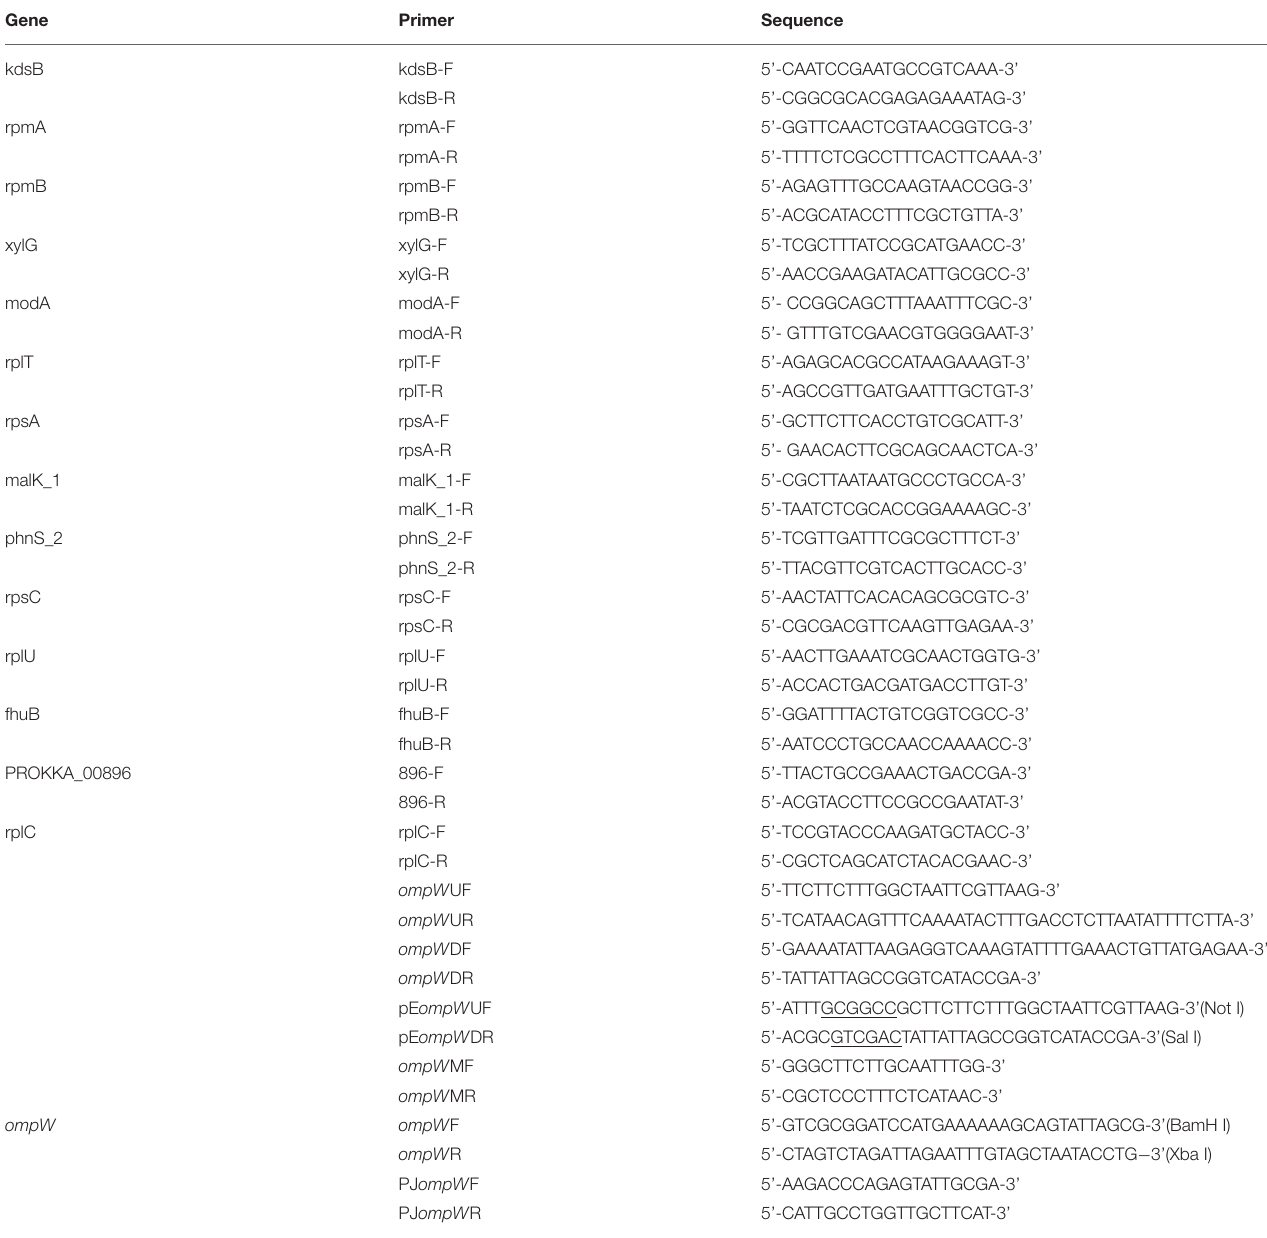
TABLE 2 | Primers used in this study.